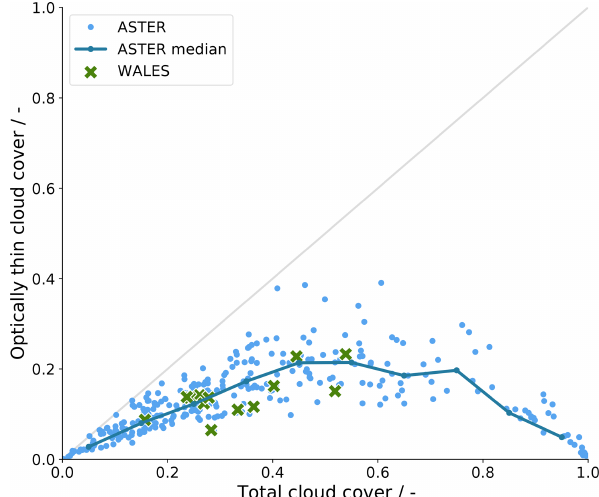
Figure 8. Change in optically thin cloud cover with total cloud cover. The blue markers correspond to values derived from 380 ASTER images (60 × 60m 2 ), with the dark blue line following along the median values. The green markers correspond to daily averaged cloud cover estimates from WALES lidar measurements. The grey diagonal line shows the maximum possible contribution of optically thin clouds to the total cloud